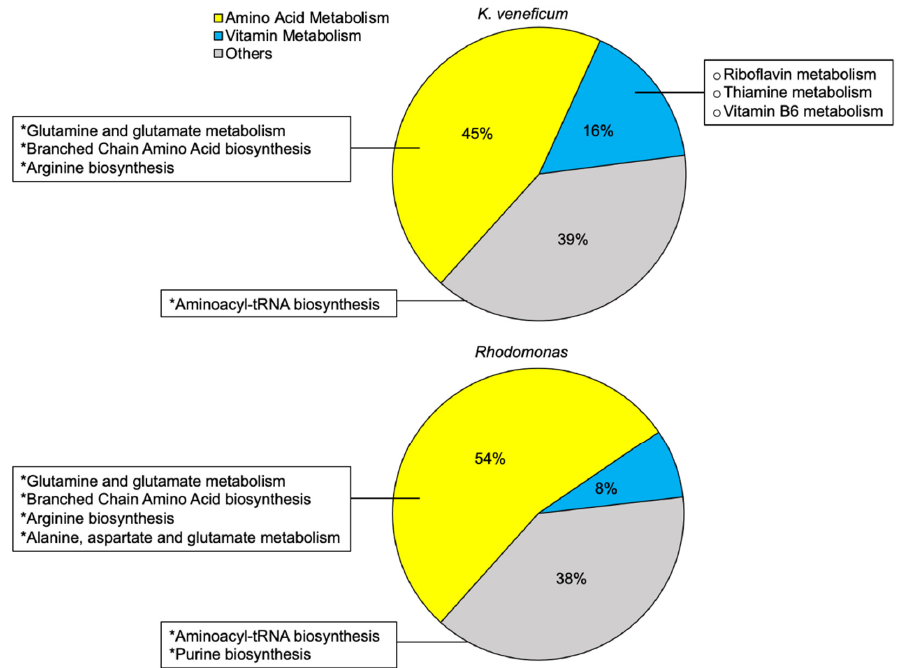
Figure 3. Metabolites that increased in the cell pellets in the algicide treatment compared to the control (>1.5-fold) were mapped to 31 KEGG pathways in Karlodinium veneficum and 26